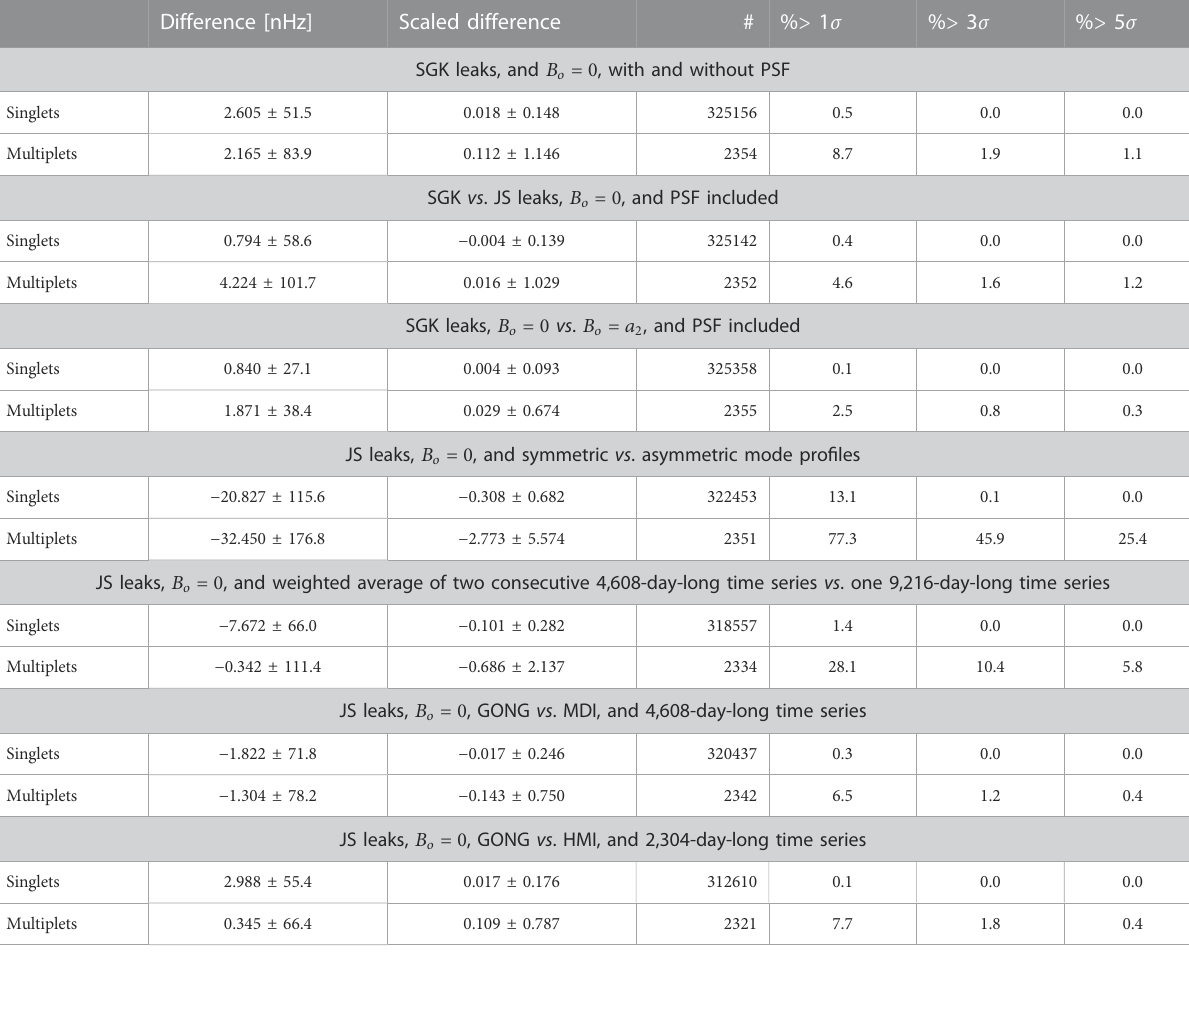
TABLE 1 Overall statistics when comparing frequencies derived using different fi tting leakage matrices of time series.